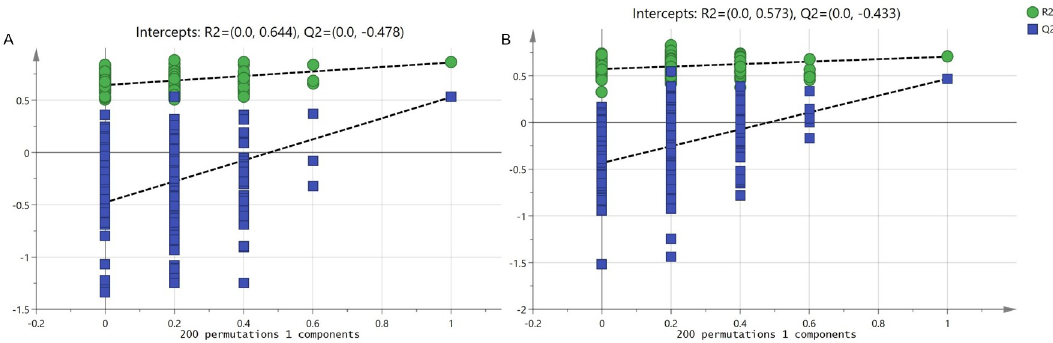
Fig 2. OPLS-DA permutation test for positive (A) and negative ion mode